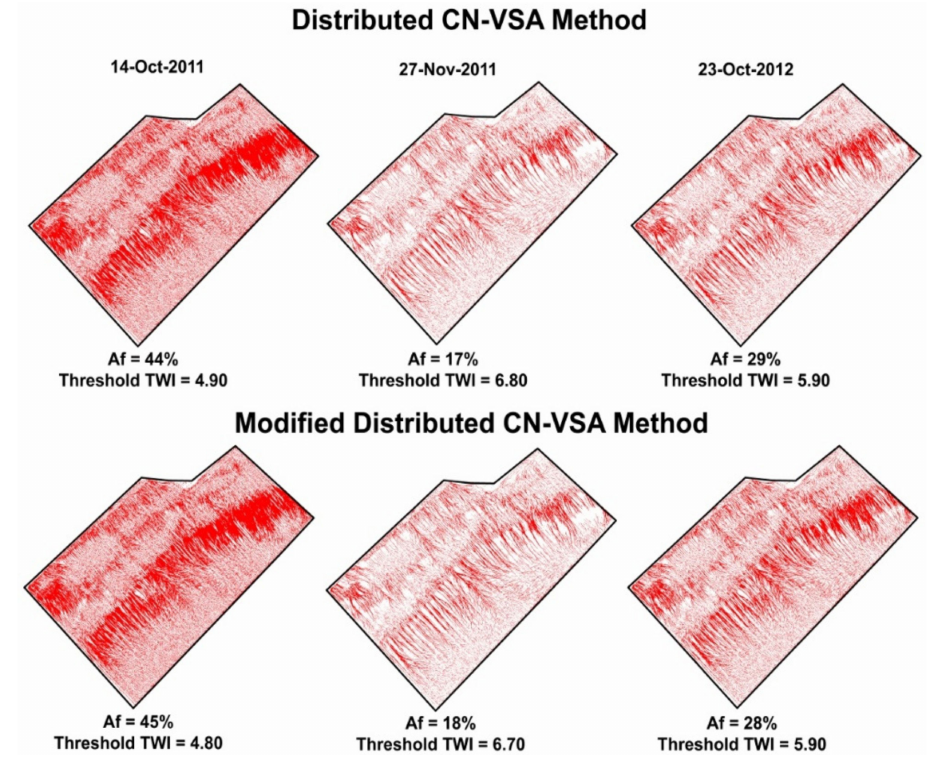
Figure 13. Comparison of spatial distribution of runoff estimated by distributed CN–VSA method and modified distributed CN–VSA method for fall rainfall